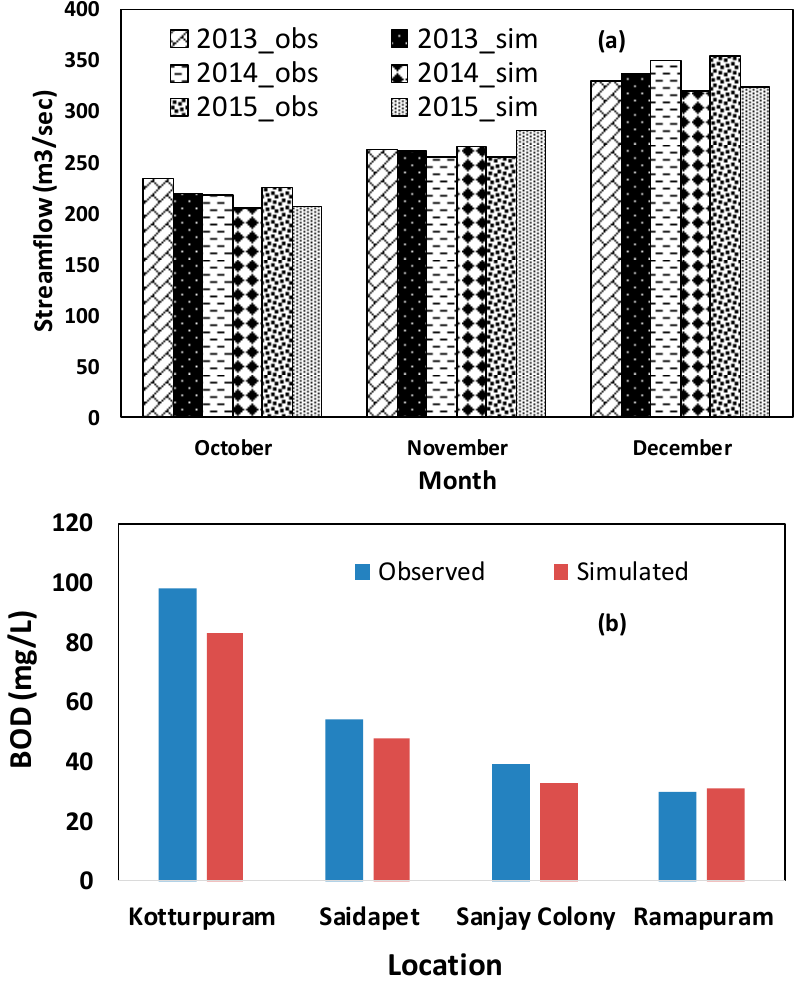
Figure 8. Comparison of simulated and observed ( a ) monthly river discharge at Sanjay Colony for years 2013–2015; and ( b ) the three months’ (October, November and December 2015) average biochemical oxygen demand (BOD) values at different locations.